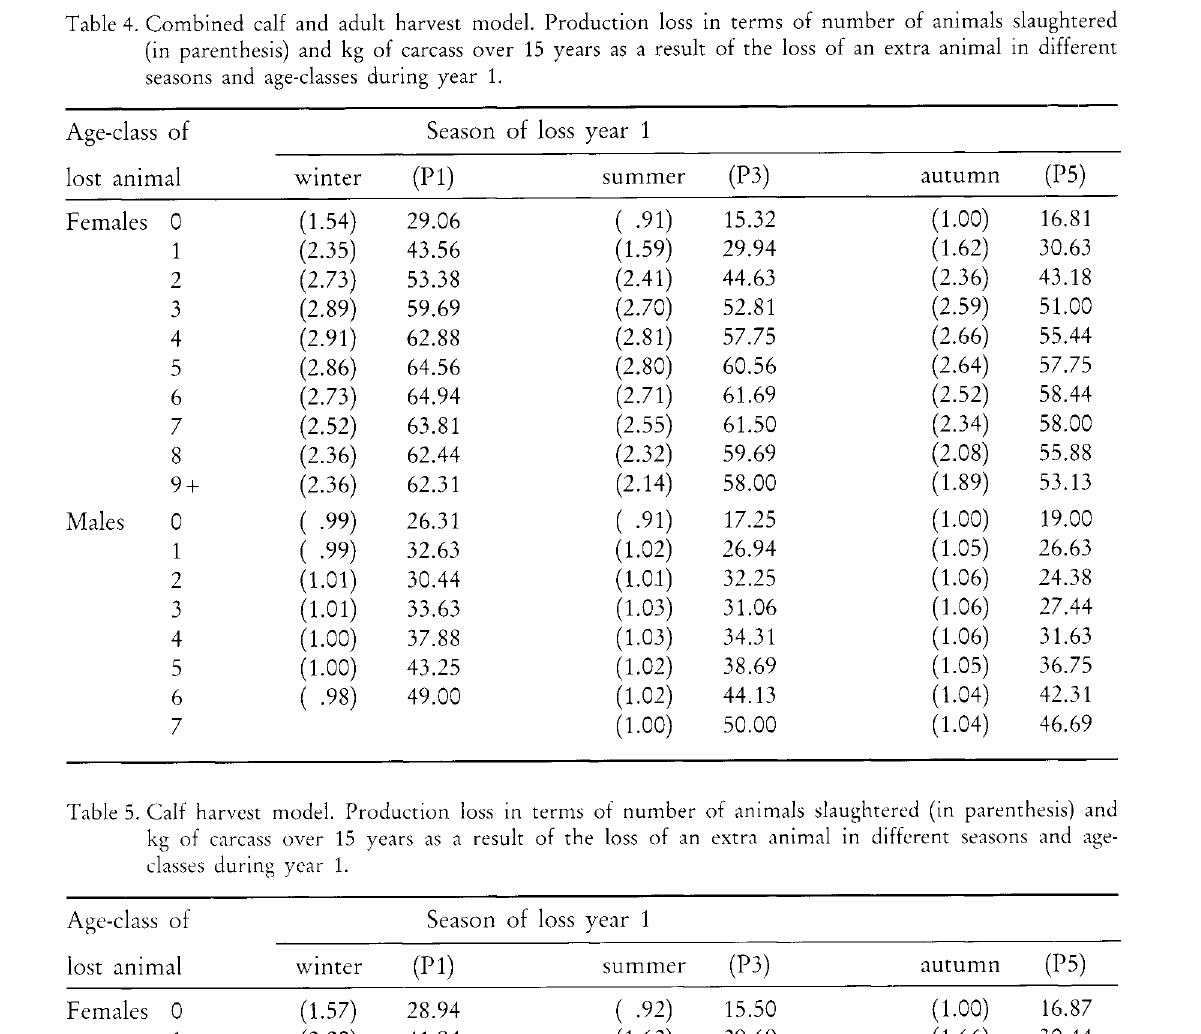
Table 5. Calf harvest model. Production loss in terms of number of animals slaughtered (in parenthesis) and kg of carcass over 15 years as a result of the loss of an extra animal in different seasons and age- classes during year